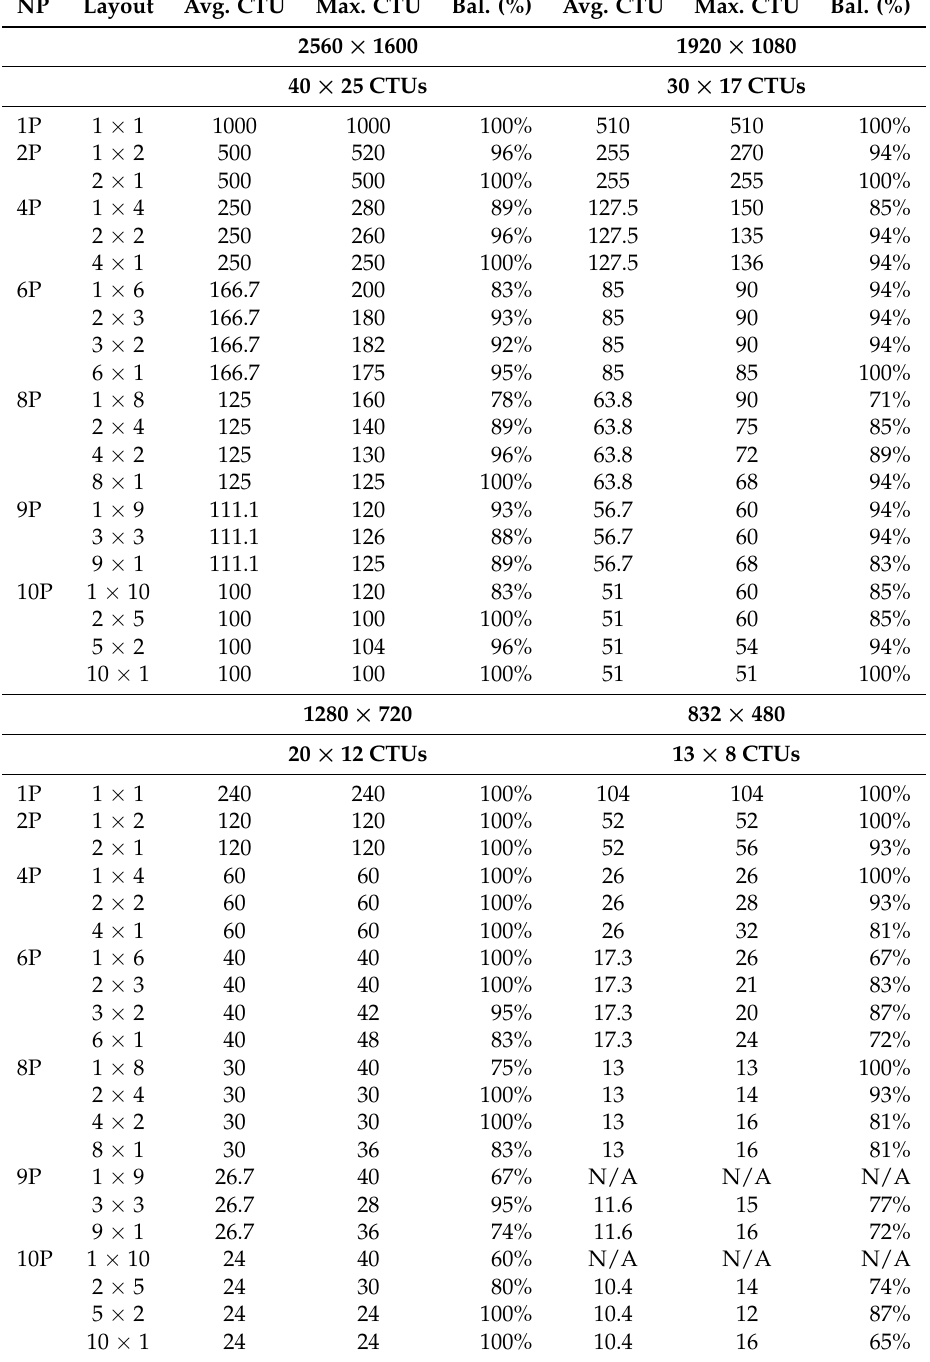
Table 4. Tile partitions and percentage of load